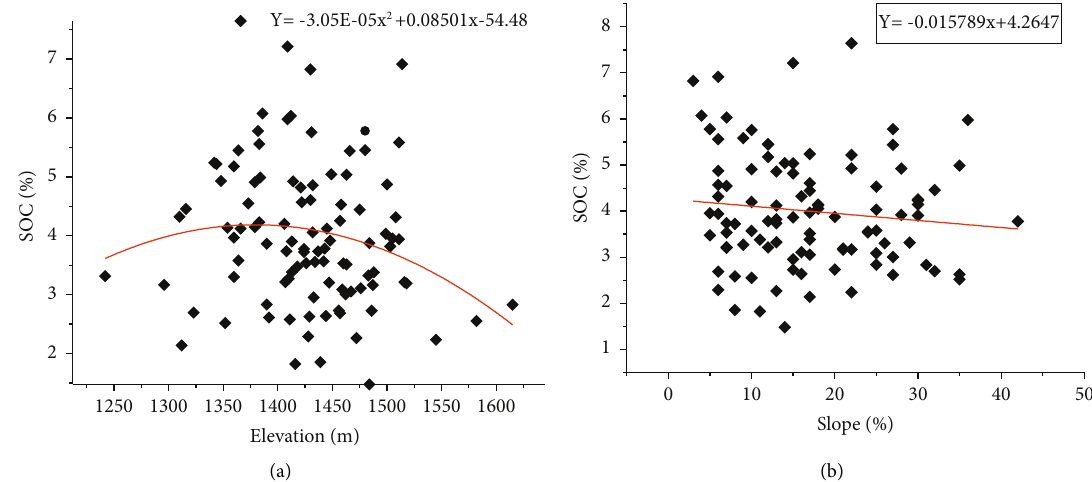
Figure 3: Response of mean SOC (%) against elevation and slope; x � the independent variable on the x -axis; y � the response variable on the y -axis; the dot and lines represent observed and fitted values of plots,